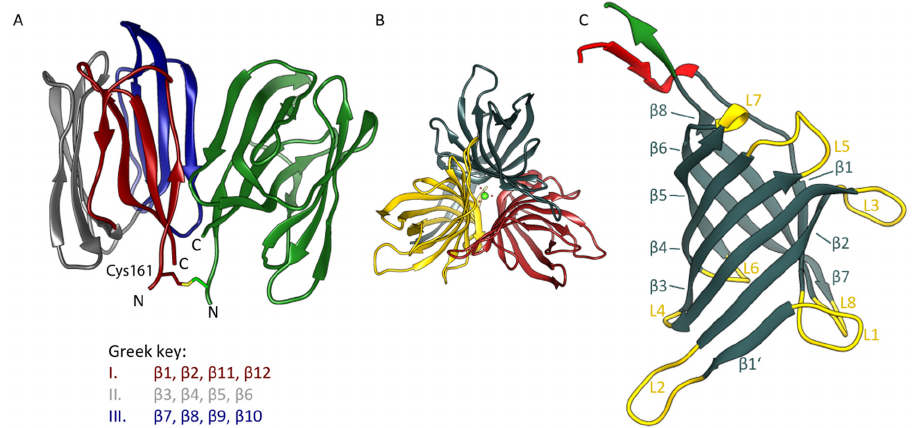
Figure 1. Structure of Os JAC1 domain proteins in ribbon representation. ( A ) JRL dimer as found in the asymmetric unit of both crystal forms, with one chain colored in grey, red, and blue, indicating the three four ‐ stranded antiparallel β‐ sheets (Greek key motifs I–III), the other monomer is coloured green. The figure is based on coordinates from crystal form 1; N ‐ and C ‐ termini (at residues Gln160 and Pro305, respectively, of full ‐ length Os JAC1) are labelled. The homodimer features a symmetric inter ‐ subunit disulfide bond at Cys161. ( B ) DIR trimer constituting the asymmetric unit of both crystal forms. The figure was prepared using coordinates from crystal form 1, including a calcium ion (green) in the center. ( C ) β‐ barrel architecture of the DIR monomer (crystal form 1, chain B). Loops (labelled L1 through L8) are highlighted in yellow and β‐ strands (labelled β 1 through β 8) shaded in metallic. The adjacent N ‐ and C ‐ terminal segments are colored red and green, respectively.